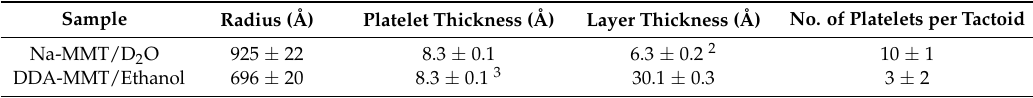
Table 3. Fitting results obtained from SANS for 0.5 wt % dispersions of Na-MMT and DDA-MMT 1 . Sample